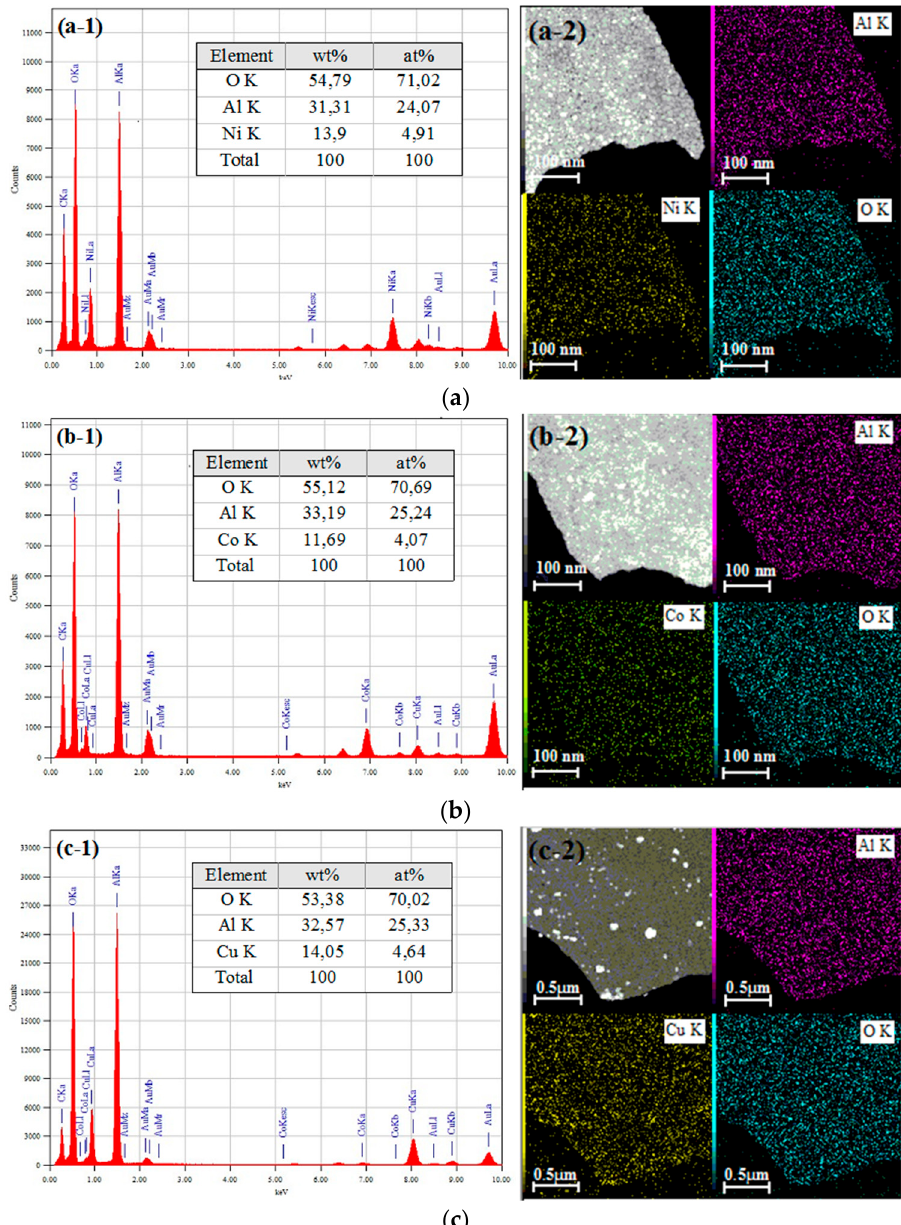
Figure 6. TEM-EDX Dot mapping analyses of ( a ) 10Ni − Al, ( b ) 10Co − Al and ( c ) 10Cu-Al calcined samples.